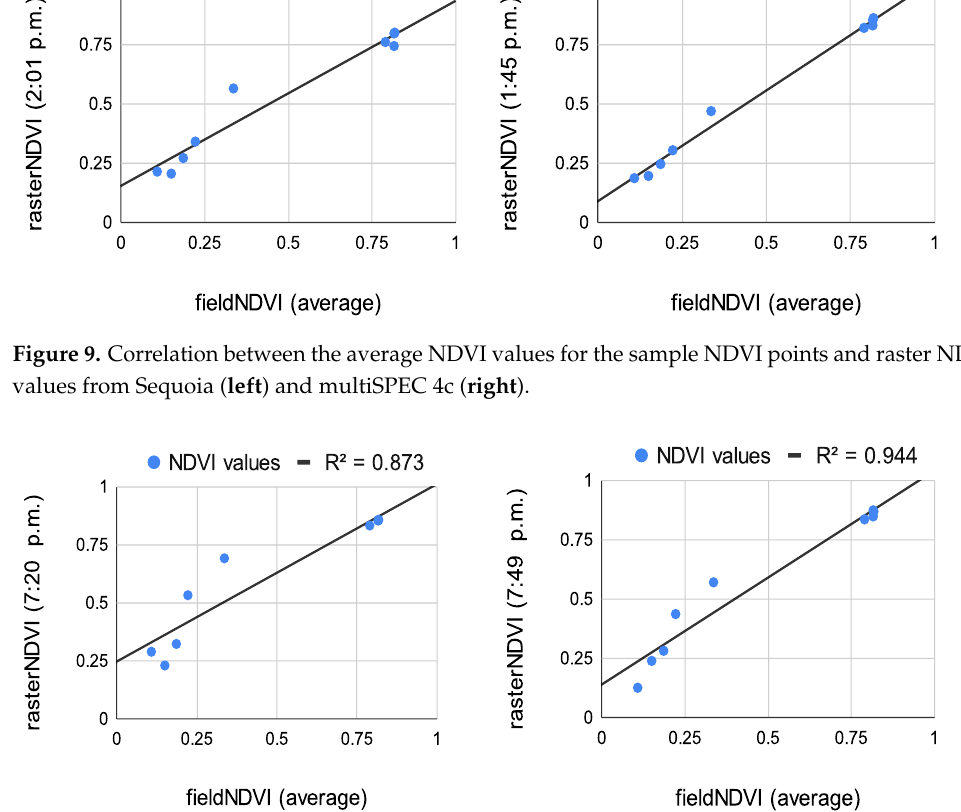
Figure 11. Left : Correlation between in situ measurements and raster values from the Sequoia sensor, flight time at 5:40 a.m. Right : Correlation between in situ measurements and raster values from the multiSPEC 4c sensor, flight time at 6:06 a.m. Figure 12. Left : Correlation between in situ measurements and raster values from the Sequoia sensor, flight time at 2:01 p.m. Right : Correlation between in situ values and raster values from the multiSPEC 4c sensor, flight time at 1:45 p.m.